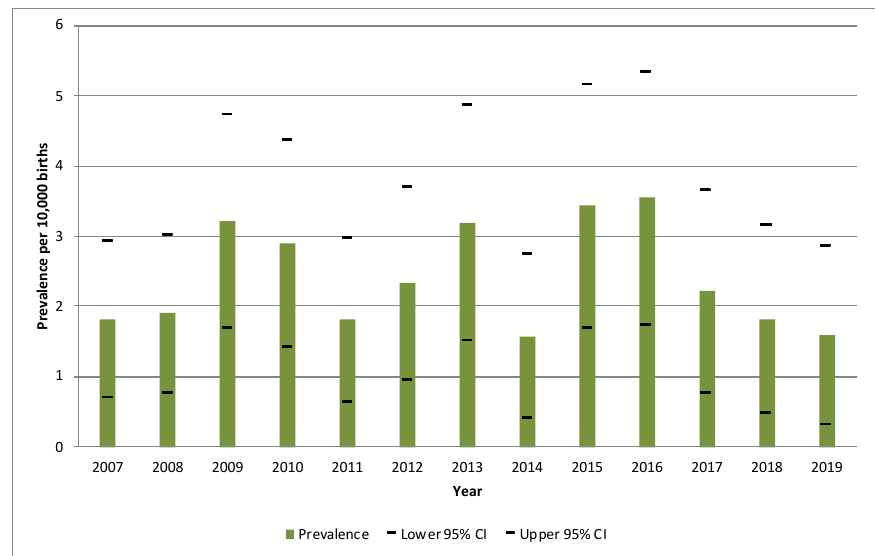
Figure 2. Annual prevalence of cases with oesophageal atresia per 10,000 births and their 95% confidence intervals during the period 2007–2019, in the Valencian Region. CI: confidence interval. Regarding the distribution by type of pregnancy ending, 97.3% (142 cases) of the OA cases were LB, 1.4% (2 cases) were SB, and 1.4% (2 cases) corresponded to TOPFA. The prevalence by type of pregnancy ending was 2.3/10,000 births (95%CI: 2.0 – 2.7) for LB and 0.03/10,000 births (95%CI: 0.0 – 0.1) for both SB and TOPFA. Table 1 shows the annual prevalence of OA cases, with or without TEF, according to the type of pregnancy ending. Table 1. Annual prevalence of cases with oesophageal atresia per 10,000 births and their 95% confidence intervals according to the type of pregnancy ending during the period 2007–2019 in the Valencian Region. Prevalence (95%CI)